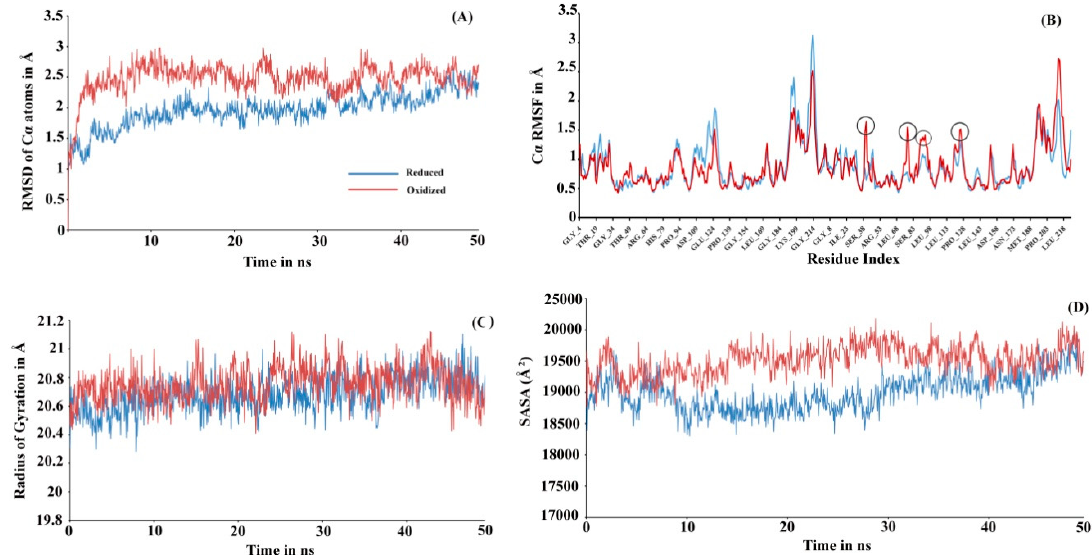
Figure 3. ( A ) RMSD, ( B ) RMSF, ( C ) Radius of gyration and (D ) SASA plot of reduced (blue) and hyperoxidized (red) Prdx6 C α atoms along the 50 ns simulation period. RMSD: Root mean square deviation; RMSF: Root mean square fluctuation; SASA: Solvent accessible surface area.